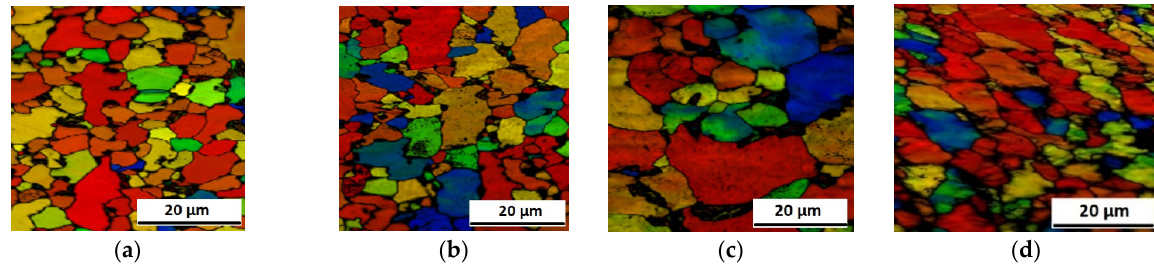
Figure 2. EBSD micrograph of Al5083 alloy after ECAP processing ( a ) no pass, ( b ) first pass, ( c ) second pass, ( d ) third pass at ambient temperature.